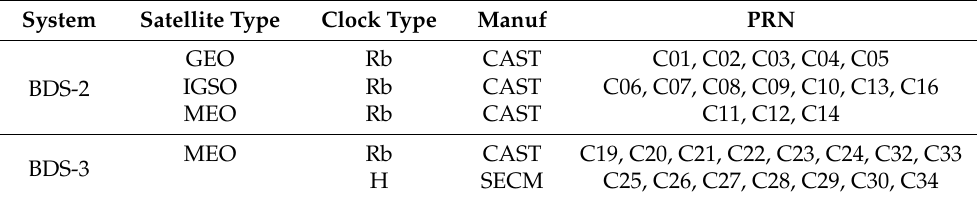
Table 2. The types of BDS satellites (http://www.csno-tarc.cn/, accessed on 14 August